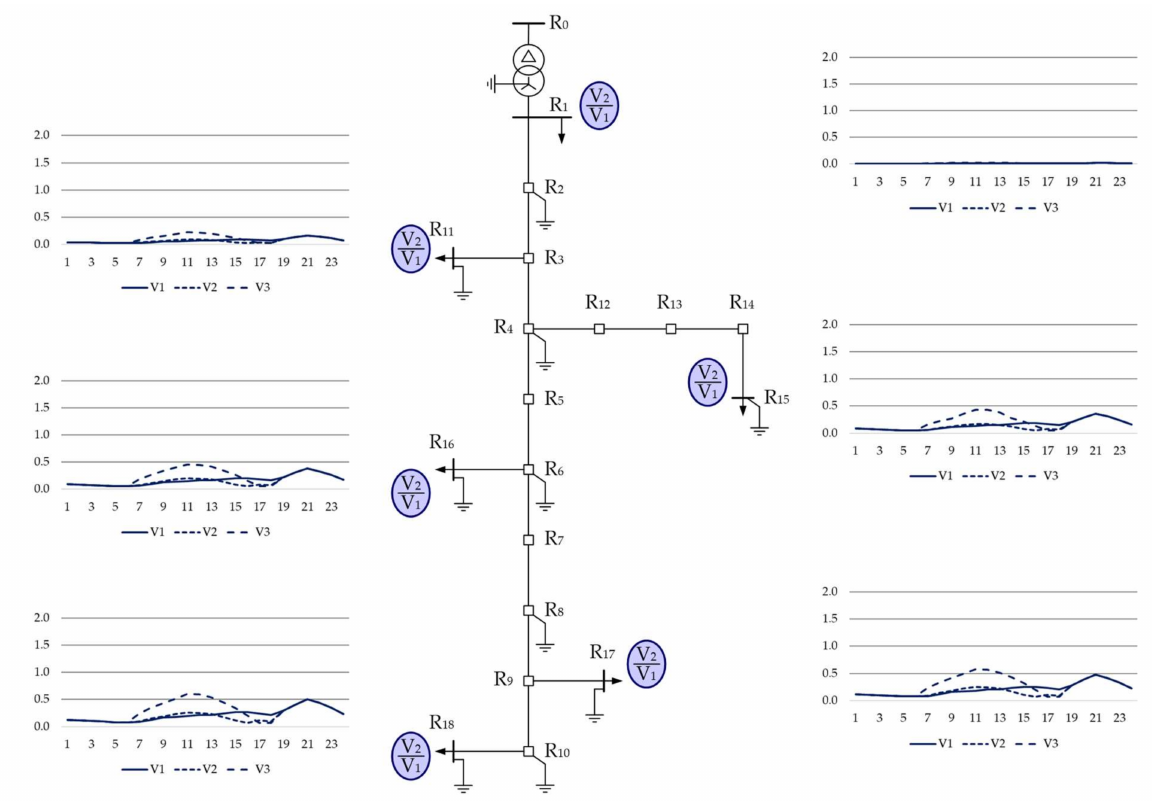
Figure 18. Daily simulation results showing the negative sequence component of the bus voltage (%) for variants V1, V2, and V3.